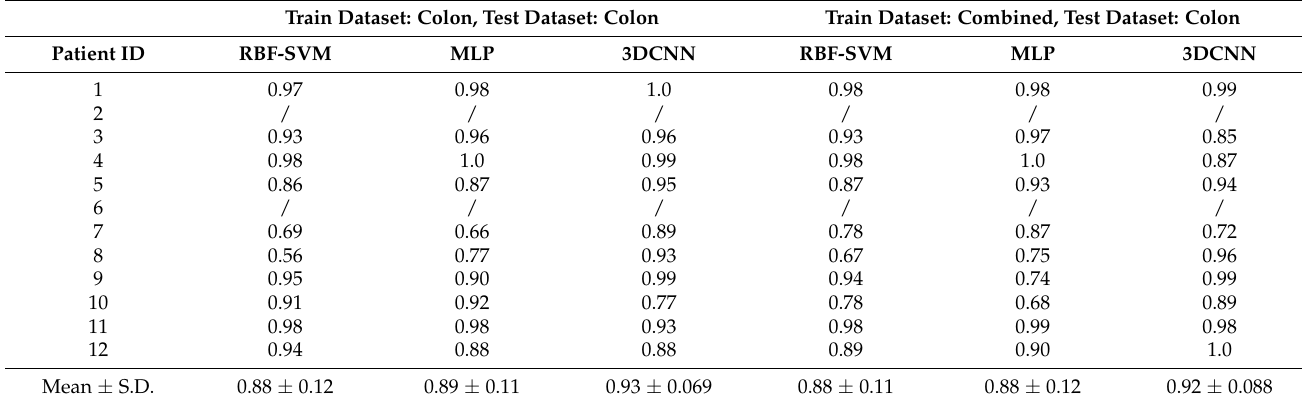
Table 3. ROC-AUC performance of different models evaluated on the colon dataset.